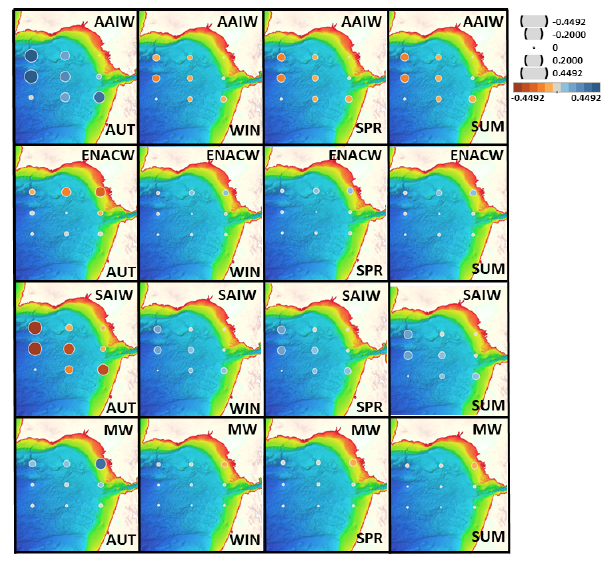
Figure 9. Illustration of the preferential tracks of the different inter- mediate water masses throughout the different seasons. Increased thickness of the arrows closer to the African coast point out the likely increase in the transport of AAIW in autumn and